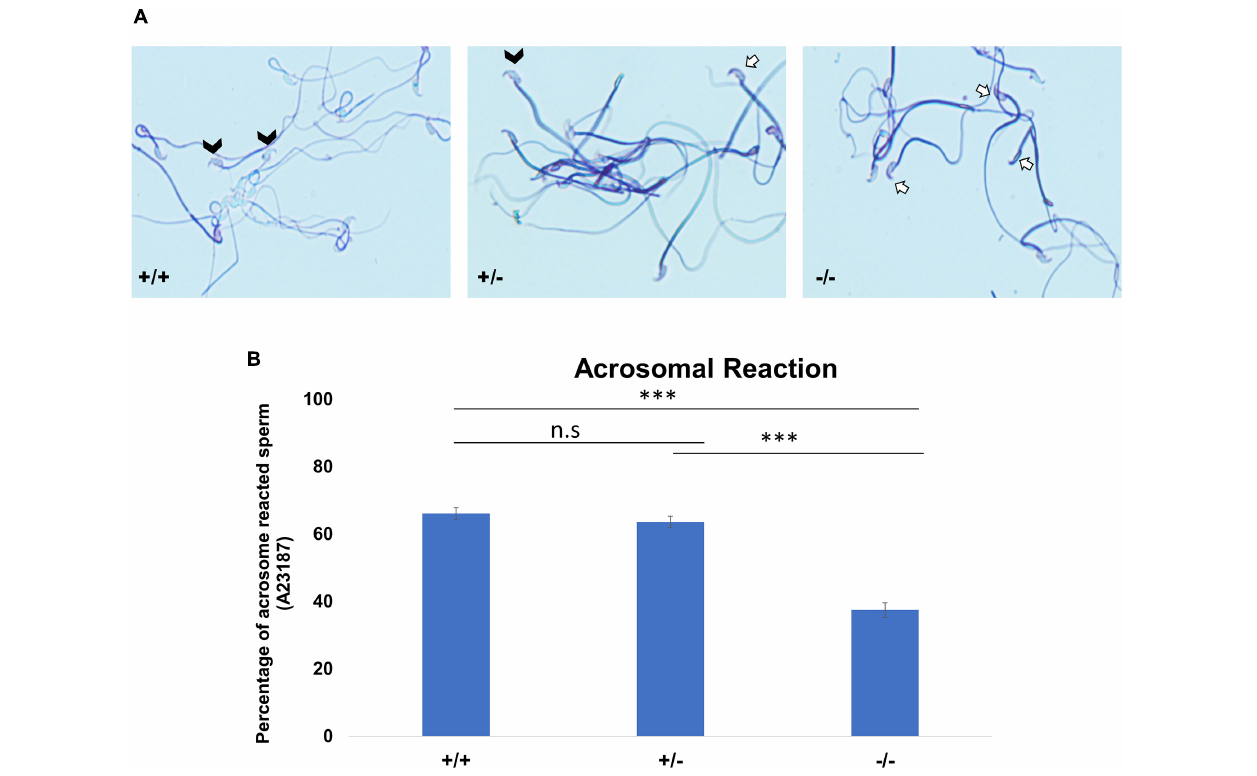
FIGURE 5 | The acrosomal reaction (AR) using calcium ionophore. (A) Coomassie-stained sperm cells of Pfn3 + / + , Pfn3 + / − , and Pfn3 − / − . Black arrow heads indicate successful acrosomal reaction took place. A white arrow indicates a crescent-shape acrosome on sperm head, indicating acrosomal reaction did not take place. (B) Percentage of acrosomal-reacted sperm for Pfn3 + / + , Pfn3 + / − , and Pfn3 − / − ( n = 3 biological replicates/genotype, ∗∗∗ p < 0.0005, Student’s t -test, one tail,